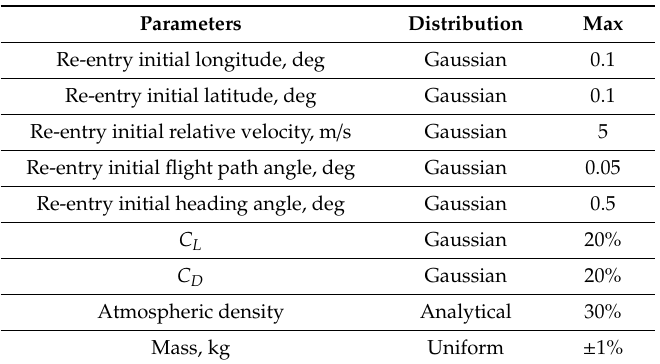
Table 2. Dispersions of re-entry interface state and other parameters.